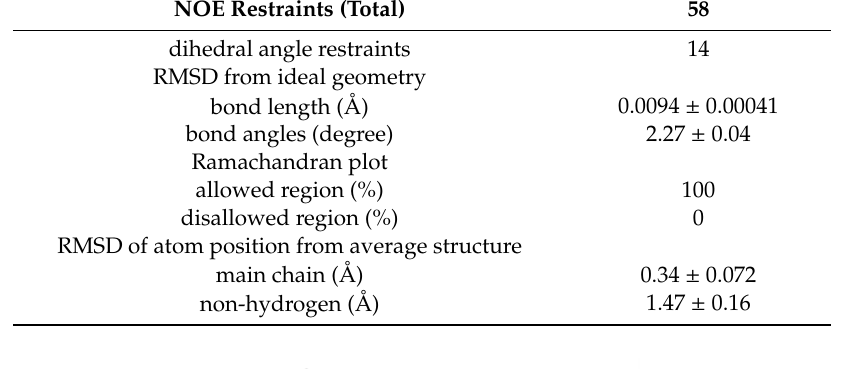
Table 2. Structure Statistics for the Ensembles of 10 Calculated Structures of LXW64.